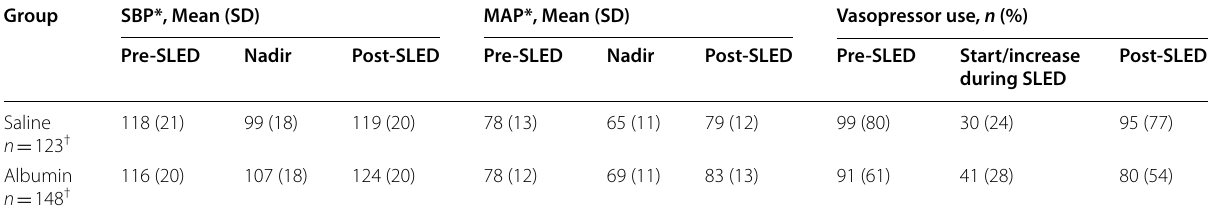
SBP: systolic blood pressure; MAP: mean arterial pressure; SLED: sustained low-efficiency